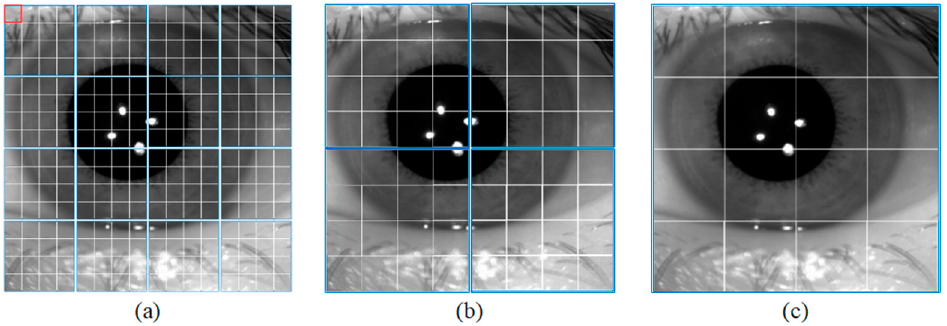
Figure 2. Window size for different blocks. ( a ) Swin Transformer Block1, ( b ) Swin Transformer Block2, and ( c ) Swin Transformer Block3.